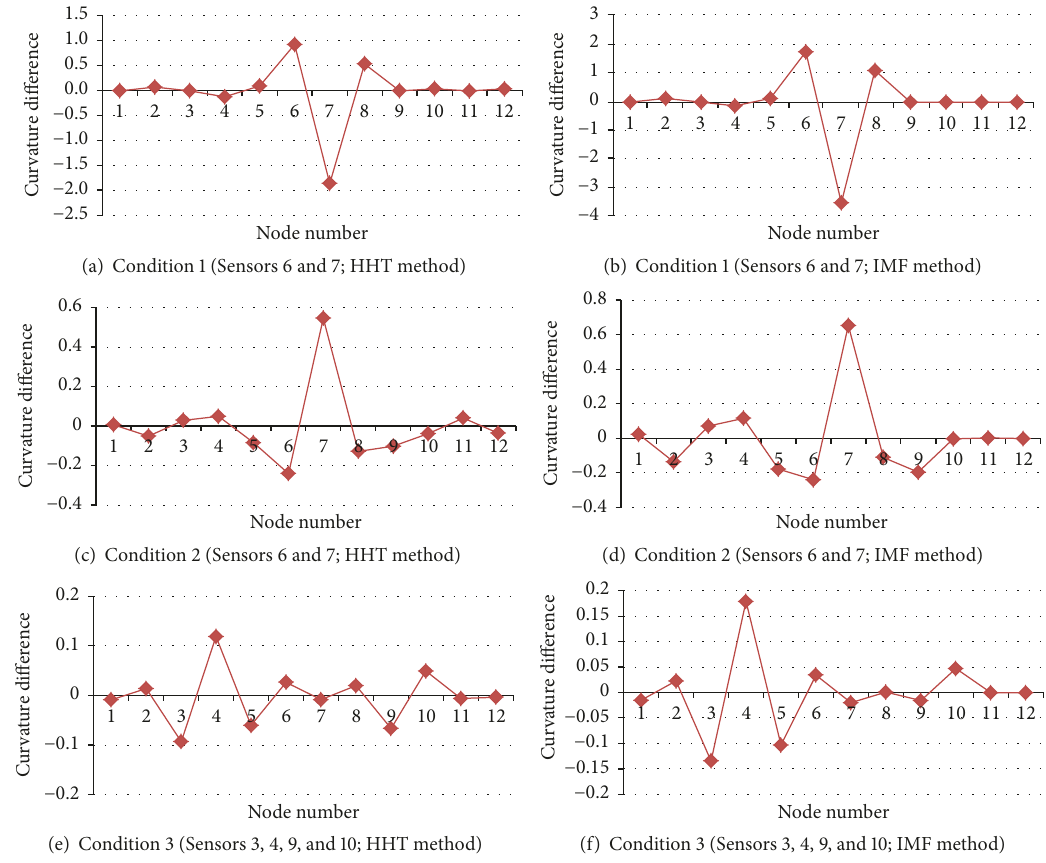
Figure 10: Relationship between the HHT marginal spectrum curvature difference or IMF instantaneous energy curvature difference and the